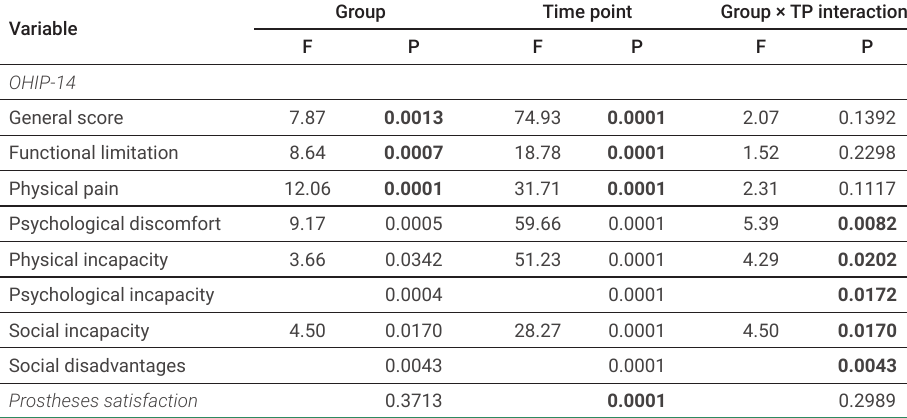
Table 1. F and P values from ANOVA to test OHIP-14 domains and prosthesis satisfaction scores.